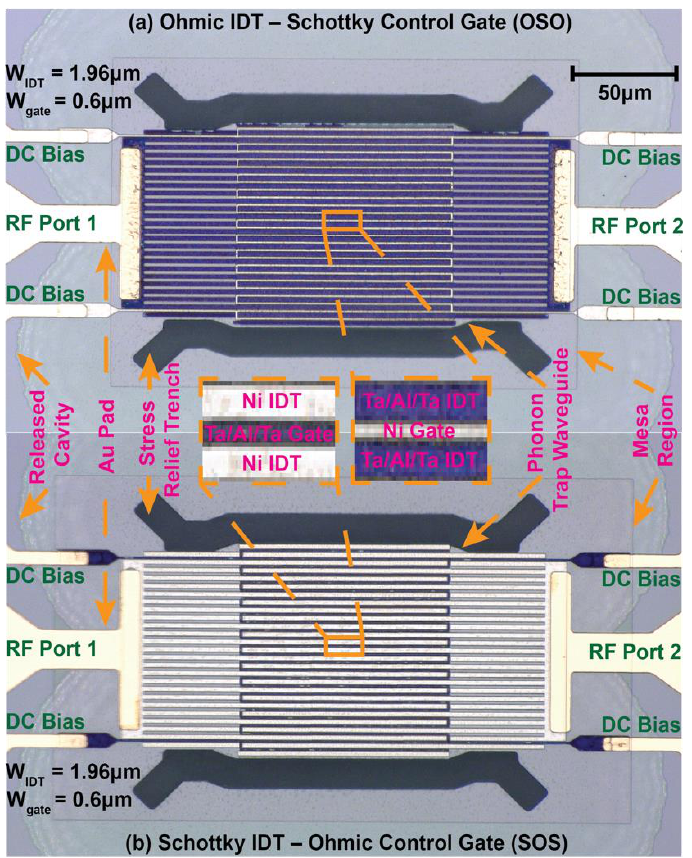
Figure 3. Optical micrographs of different switchable transducers with meandering control gates: ( a ) Ohmic IDT–Schottky control gate (OSO) and ( b ) Schottky IDT–Ohmic control gate (SOS). IDTs and control gates are shown in the inset.